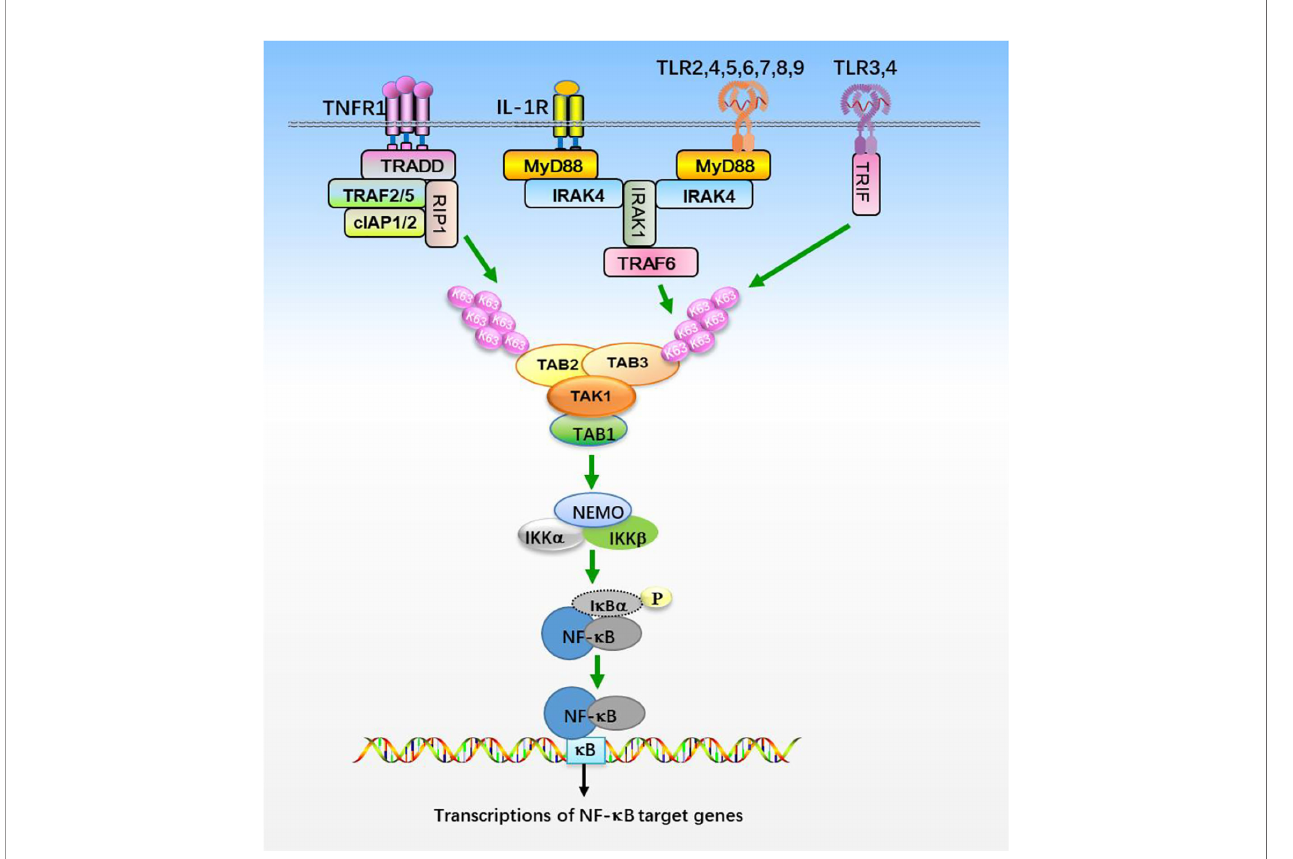
FIGURE 1 | The NF- k B signaling pathway. Stimulation of TNFR1, IL-1R, and TLRs with their ligands promotes recruitments of the indicated adaptor proteins and E3 ligases, which catalyzes the synthesis of K63-linked polyubiquitin chains that preferentially bind to TAB2 and TAB3 subunits, resulting in the assembly and activation of TAK1-TABs complex. TAK1-TABs then phosphorylates IKKs, which activates transcription factor NF- k B and elicits the transcription of downstream